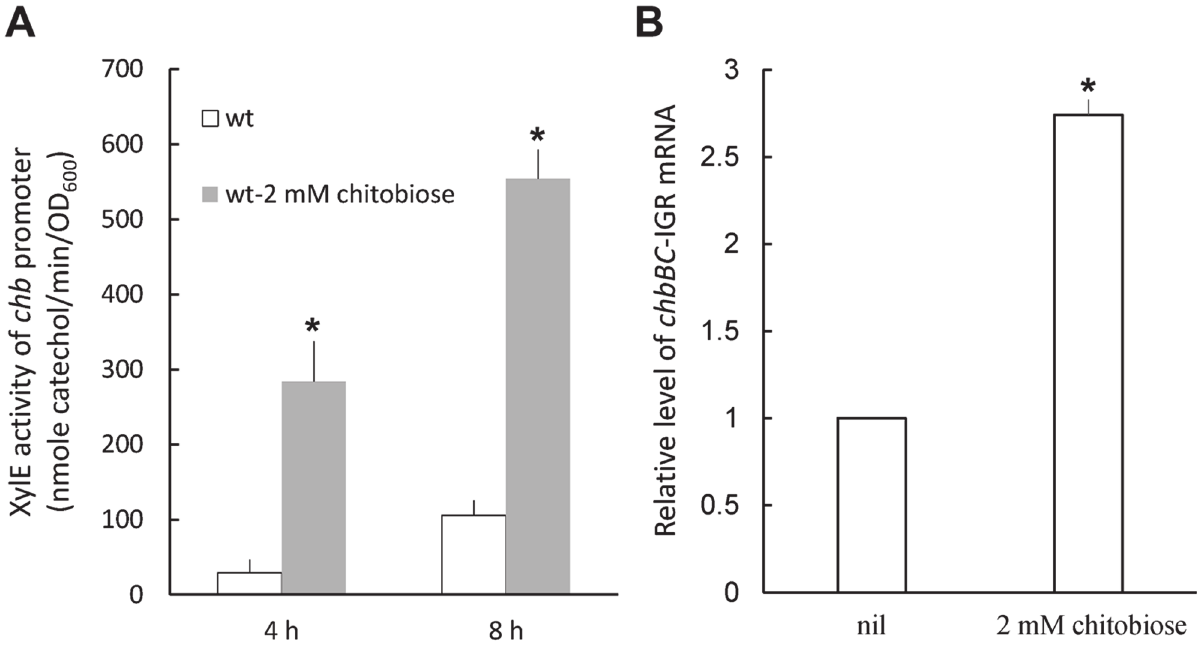
Fig 5. (A) Chitobiose induced chb promoter activity. The xylE activity in the chb-xylE reporter plasmid-transformed wild-type P. mirabilis in the presence or absence of 2 mM chitobiose was measured after induction for 4 h and 8 h. (B) Chitobiose induced expression of chb mRNA. The RNA of the